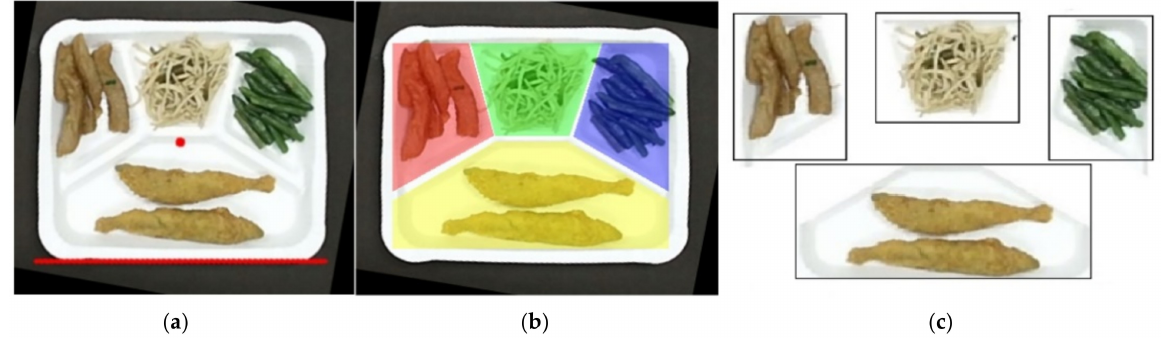
Figure 7. Plate normalized form and the segmentation of food items with a predefined mask: ( a ) the plate image center; ( b ) the four grids with different colors; ( c ) the segmented